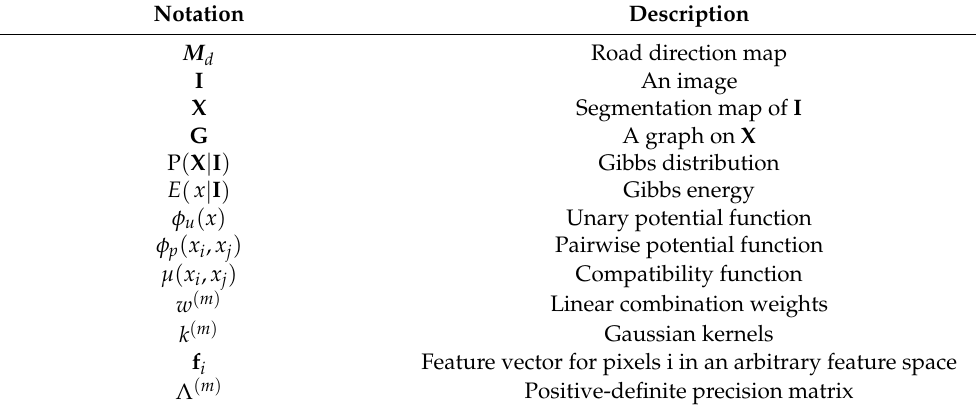
Table 1. Description of